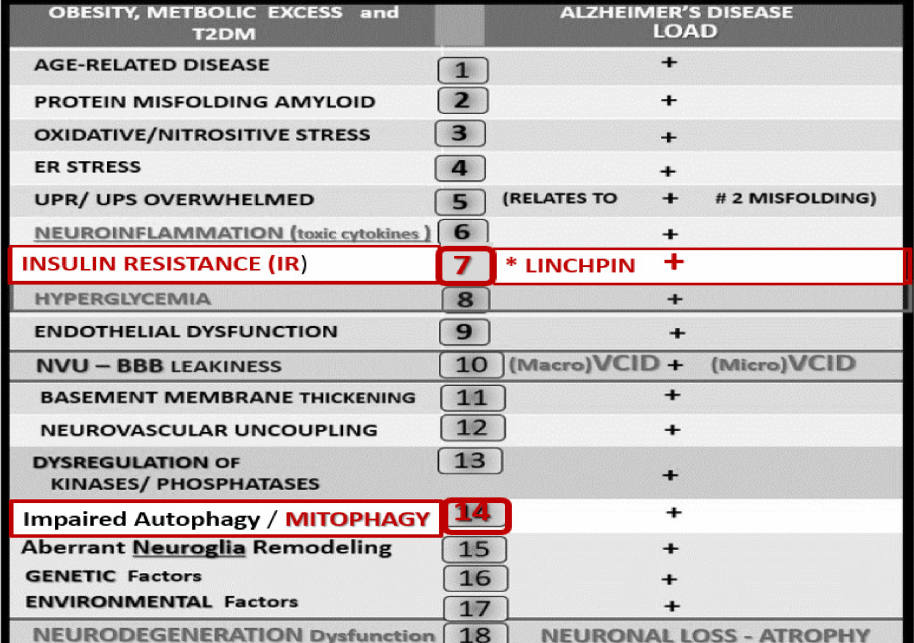
Figure 13. There are multiple intersecting risks between obesity, metabolic syndrome (MetS), insulin resistance (IR), type 2 diabetes (T2DM), and late-onset Alzheimer’s disease (LOAD). This figure depicts at least 18 intersecting risks or links between these two disparate chronic age-related diseases. Importantly, these intersecting risks may contribute to the increased risk of LOAD in those individuals with obesity, MetS, IR, and T2DM. Additionally, advanced glycation end products (AGE) and its receptor, the receptor for advanced glycation end products (RAGE) are important to number 8 hyperglycemia in generating reactive oxygen species and AGE could also complete with RAGE for A β degradation. Note that IR (number seven with asterisk) is highlighted in red as it may be considered to be the linchpin between T2DM and LOAD and further emphasizes its central role and location of IR in the MetS in previous Figure 4. Additionally, note that impaired autophagy/mitophagy (number 14) is also highlighted in red due to its role in the accumulation of aberrant mitochondria. Modified with permission by CC 4.0 [36]. A β = amyloid beta; BBB = blood-brain barrier; ER = endoplasmic reticulum; NVU = neurovascular unit; UPR/UPS = unfolded protein response/unfolded protein response—endoplasmic reticulum